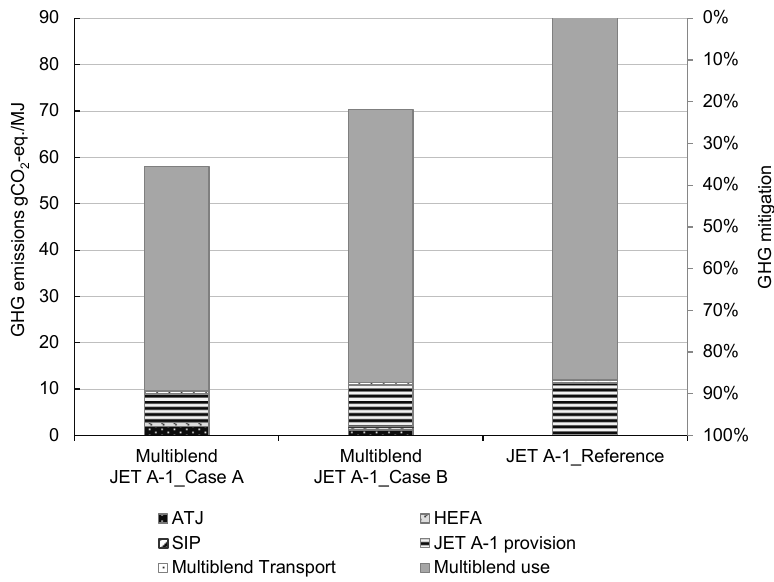
Figure 6. GHG emissions and GHG mitigation potential of the multiblends for the supply chains case A and case B compared to the JET A-1 reference.